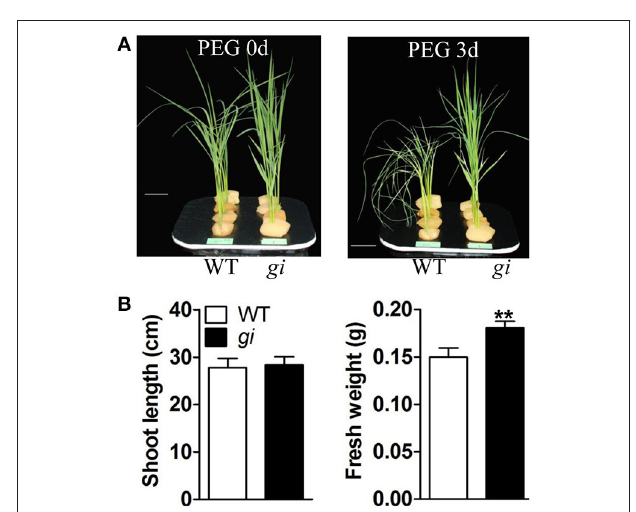
FIGURE 3 | Growth characteristics of WT, L1, L2 and osgi plants under PEG-treated conditions. (A) 15-day-old WT, L1, L2 and osgi seedlings (left) were treated in 21% PEG-conditioned culture media for 3 days (right). (B) Absolute fresh weight or (C) fresh weight relative to the strain-matched control of WT, L1, L2 and osgi plants grown in control or PEG-treated culture media. (D) Water contents in WT, L1, L2 and osgi leaves were measured 24, 48, and 72 h after PEG treatment. All data represent the mean of three biological replicates, with error bars indicating SD. Significant differences relative to the corresponding WT strain are indicated with asterisks ( ** P < 0.01; and * P < 0.05). Bars = 4cm.